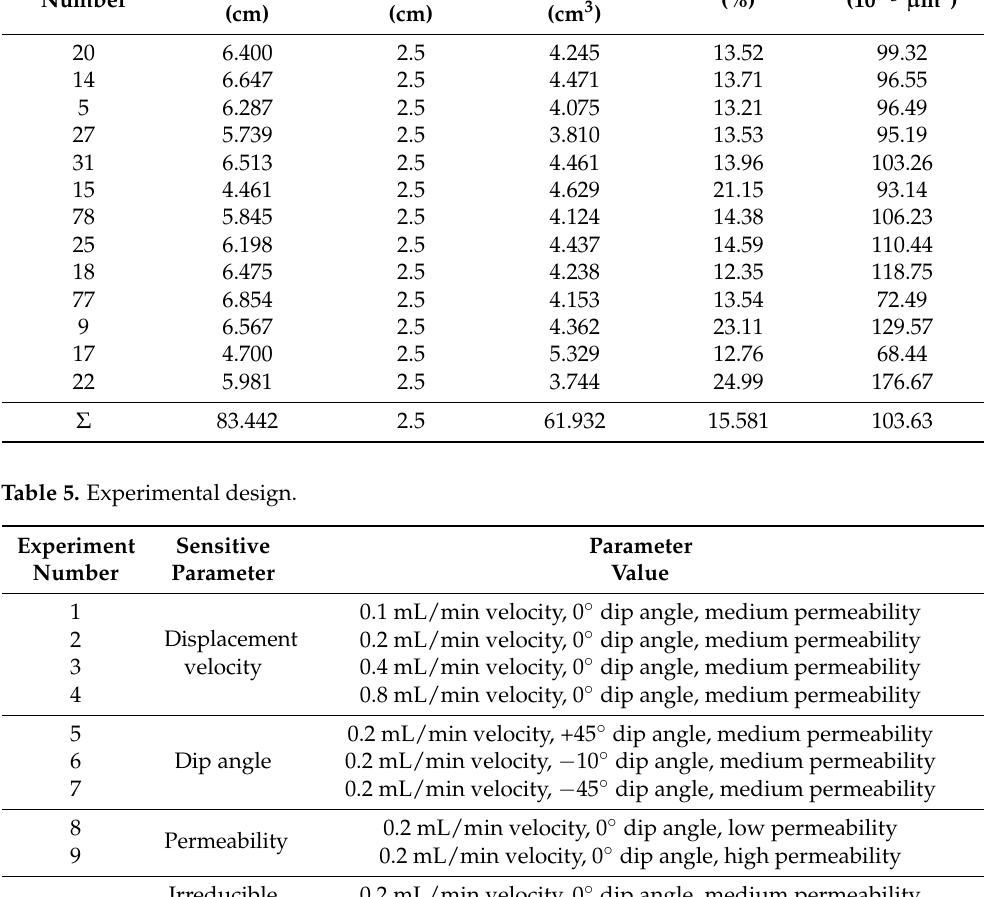
Figure 3. Schematic of the long core displacement process. 2.3. Procedure The experiments adopted constant velocity displacement method for displacing un- der the condition of 80 °C and 8 MPa (i.e., the back pressure). The main steps are as fol- lows: 1. The CH 4 contained in the cores were displaced by connecting the CO 2 container until the CO 2 content of outlet reached more than 98% or until the recovery rate of CH 4 did not increase. The displacement speed was set as experimental design; the back pressure was set to 8 MPa; and the composition of produced gas was recorded every